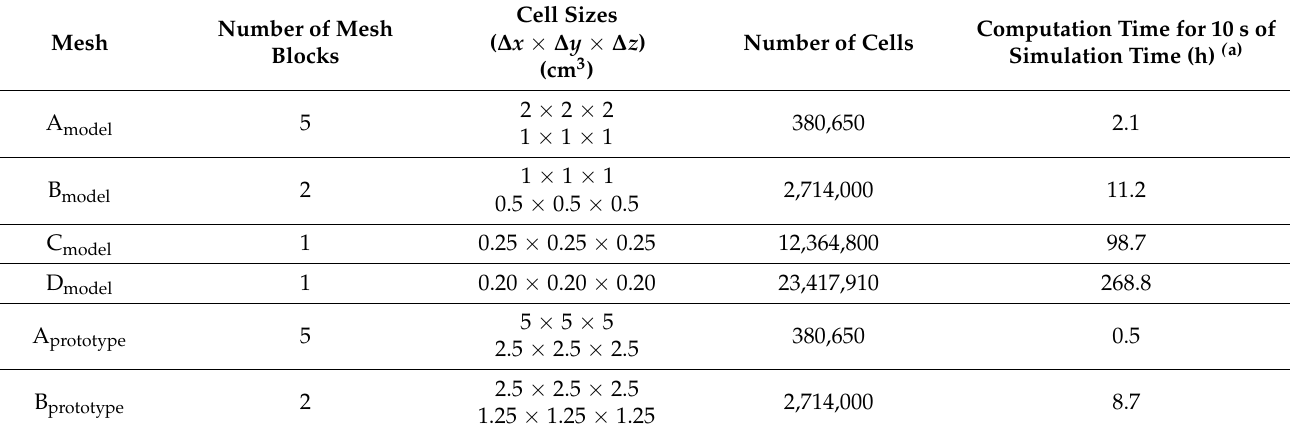
Table 1. Characteristics of the numerical